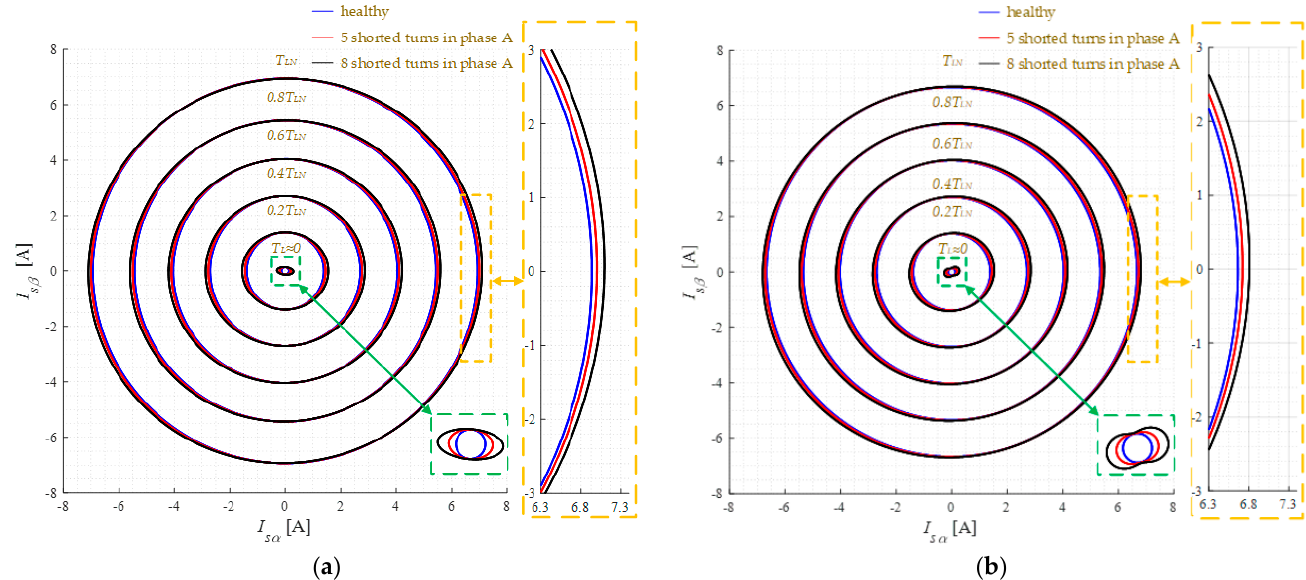
Figure 9. The current space vector hodograph for an undamaged and a damaged motor: scalar control ( a ), field-oriented control ( b ); 5 and 8 shorted turns in stator winding; f s = 100 Hz.